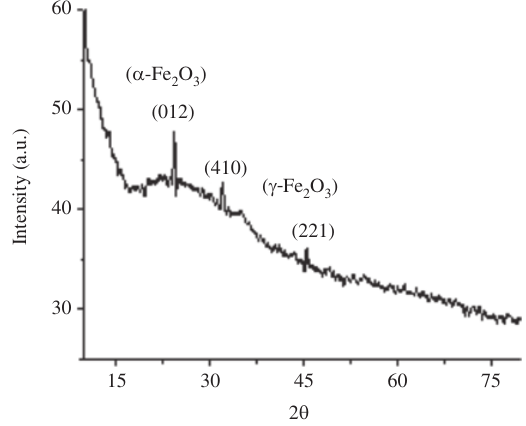
Figure 2: X-ray diffraction pattern of iron oxide nanoparticles.